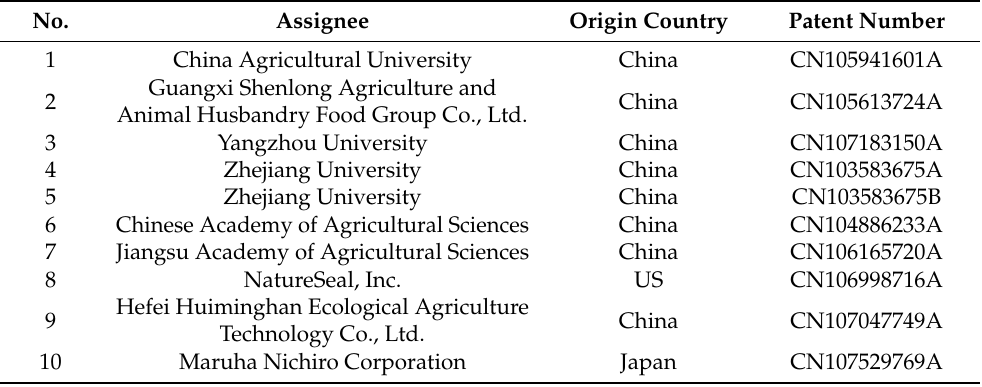
Table 6. Top ten forward citing